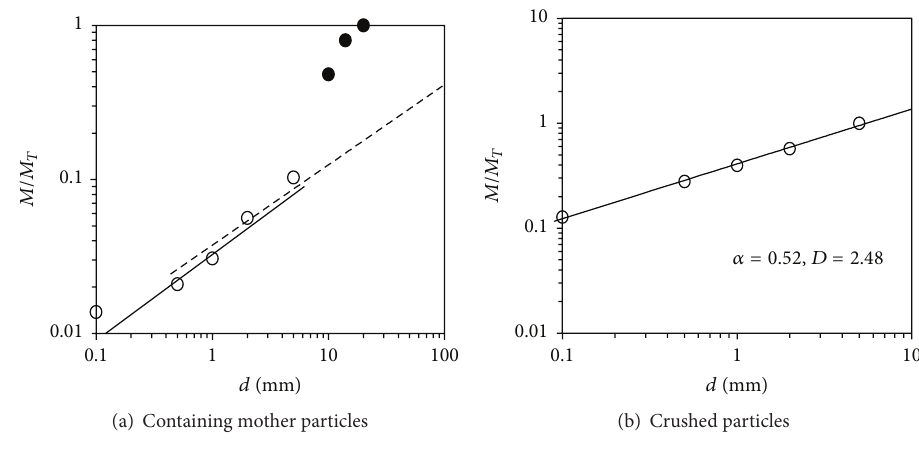
Figure 8: Particle size